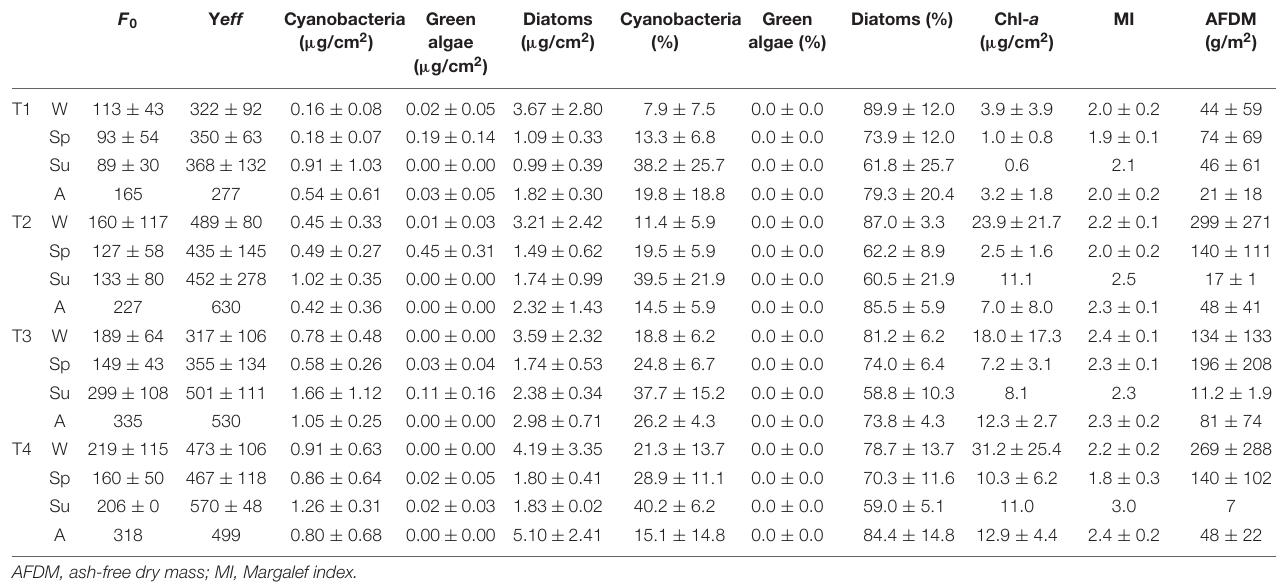
TABLE 2 | Mean value and standard deviation of biological variables evaluated for different sampling sites (T1–T4) in upper Ter River basin (NE Catalonia, Spain) in 2019, in winter (W), spring (Sp), summer (Su), and autumn (A).